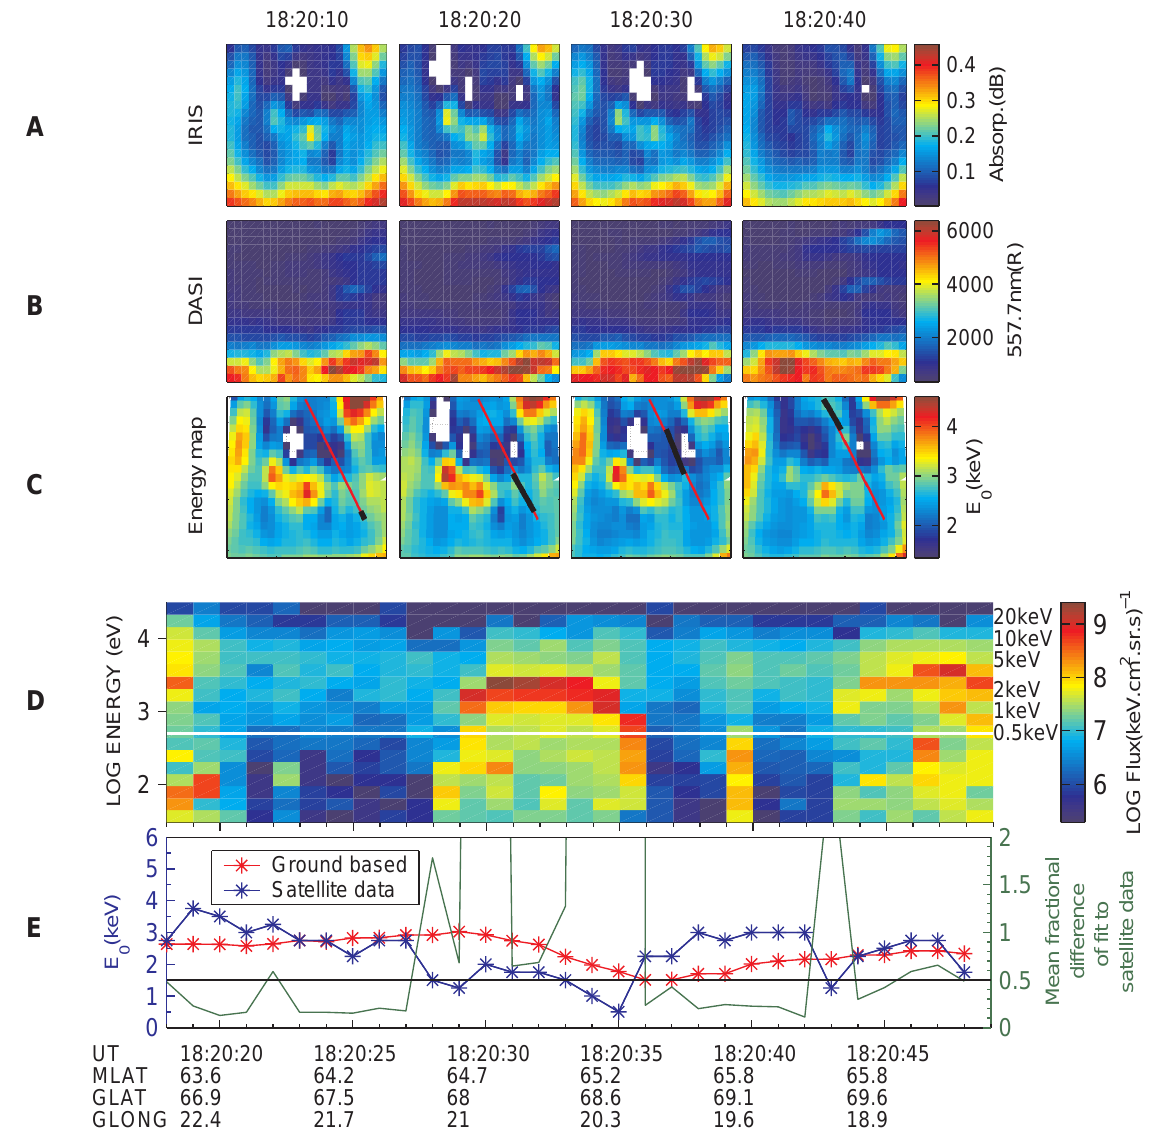
Fig. 2. Data from 6 January 2000, DMSP (F15) conjunction over northern Scandinavia ( K p =3). Panels (A) , (B) and (C) are absorption, optical intensity and energy map images, respectively, corresponding to the area covered by the IRIS and DASI common field of view (67.8–70.2 ◦ N and 17.75–23.75 ◦ E) with north and east oriented up and right, respectively. Panel (D) is the satellite electron energy spectro- gram. Panel (E) shows the characteristic energies derived from satellite (blue) and energy map images (red). The green curve is an indication of how non-Maxwellian the satellite spectra